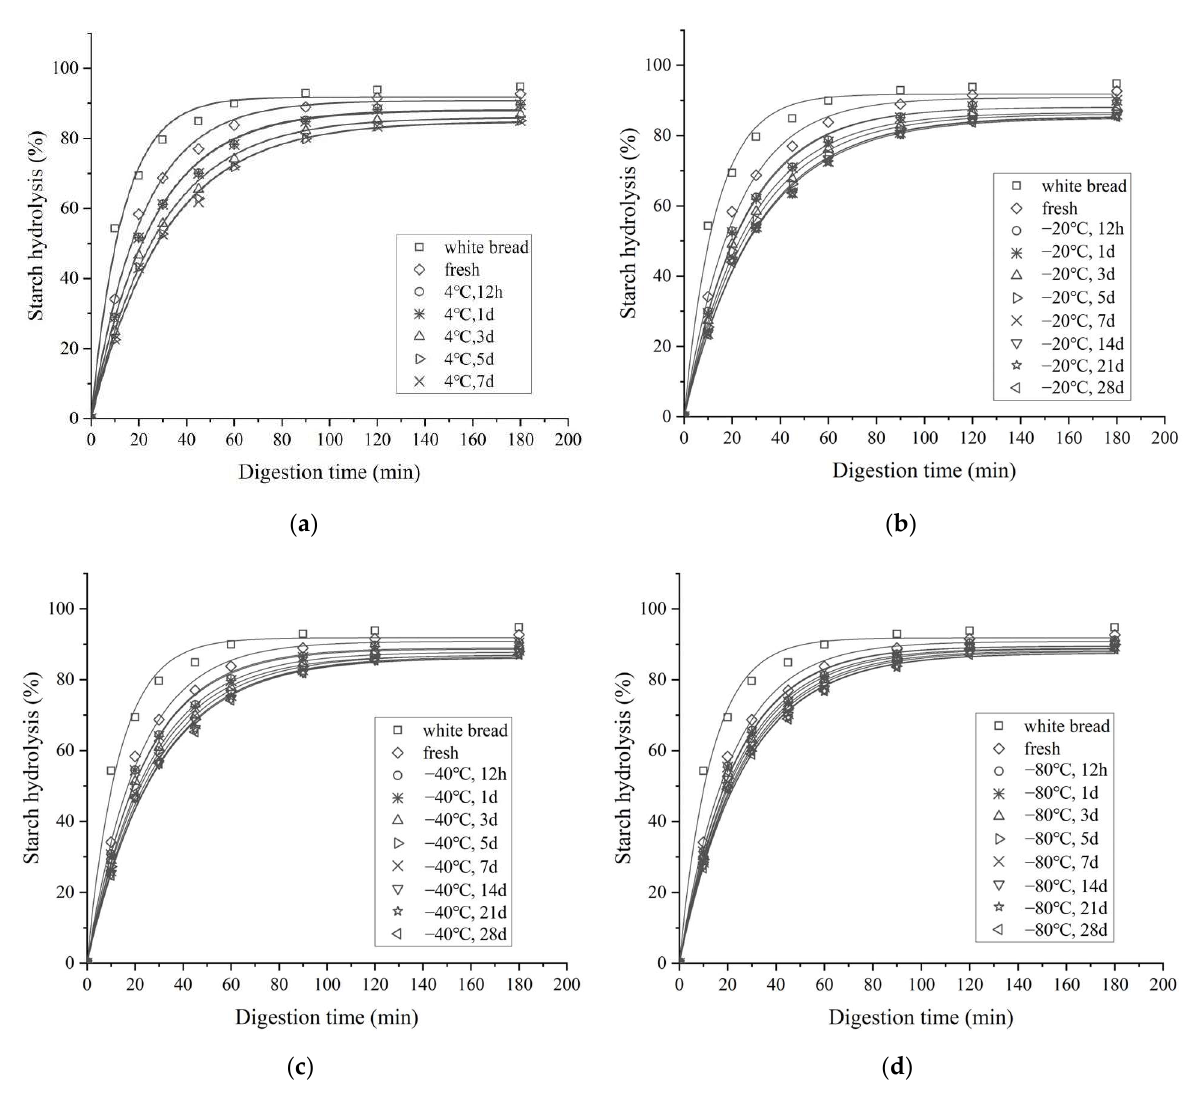
Figure 3. Starch hydrolysis profiles of cooked rice under different storage temperatures and periods. ( a ) 4 °C; ( b ) −20 °C; ( c ) −40 °C; ( d ) −80 °C. Table 1. Effect of storage temperatures and periods on the hydrolysis kinetics of cooked rice